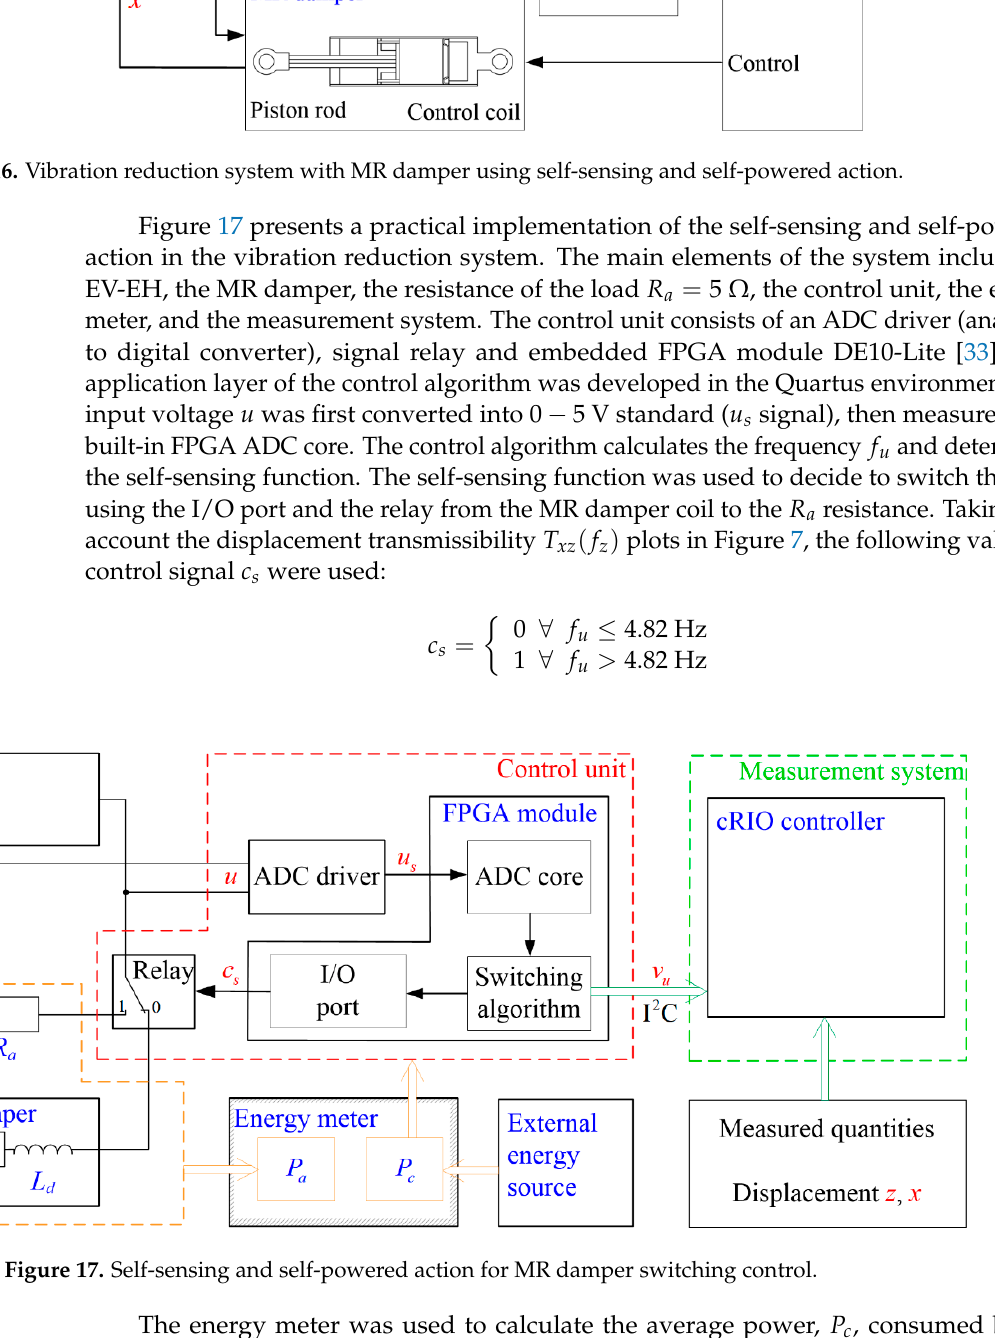
Figure 16. Vibration reduction system with MR damper using self-sensing and self-powered action.